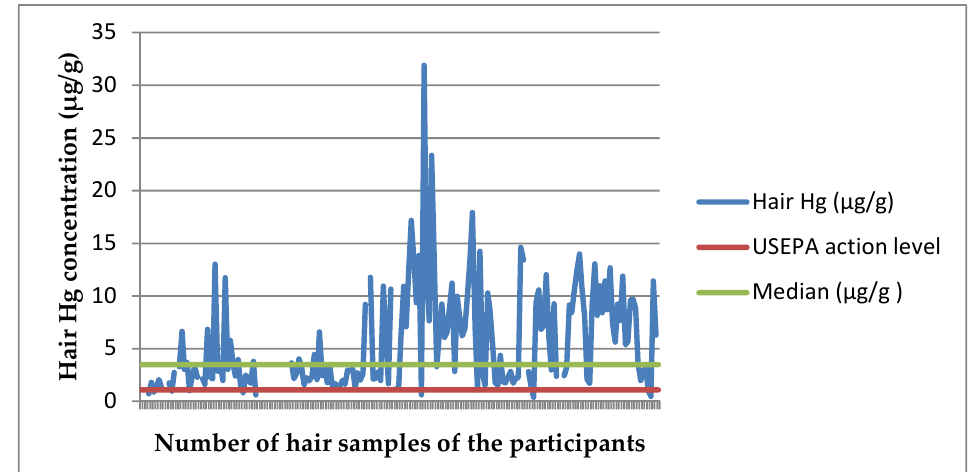
Figure 2. Total mercury concentrations in hair samples of 178 study participants.